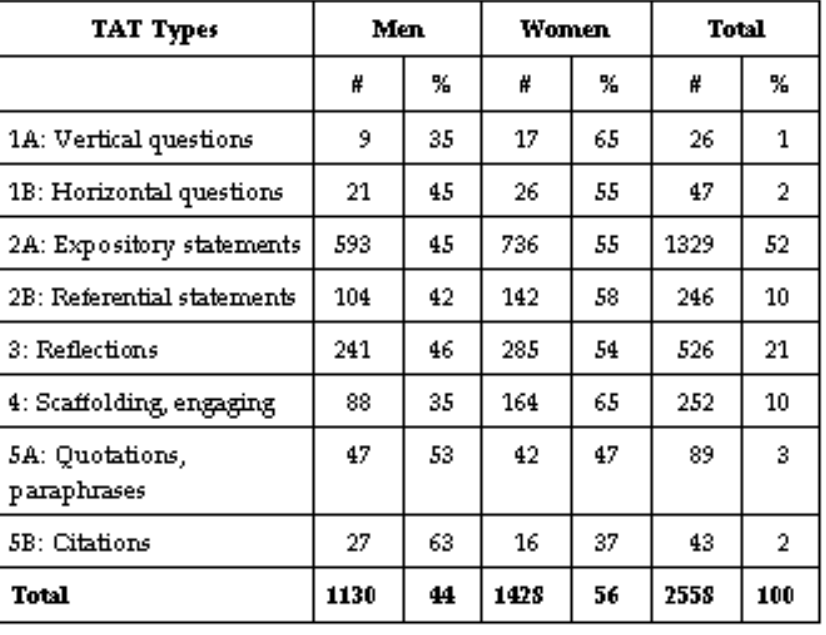
Table 3: Frequency of TAT